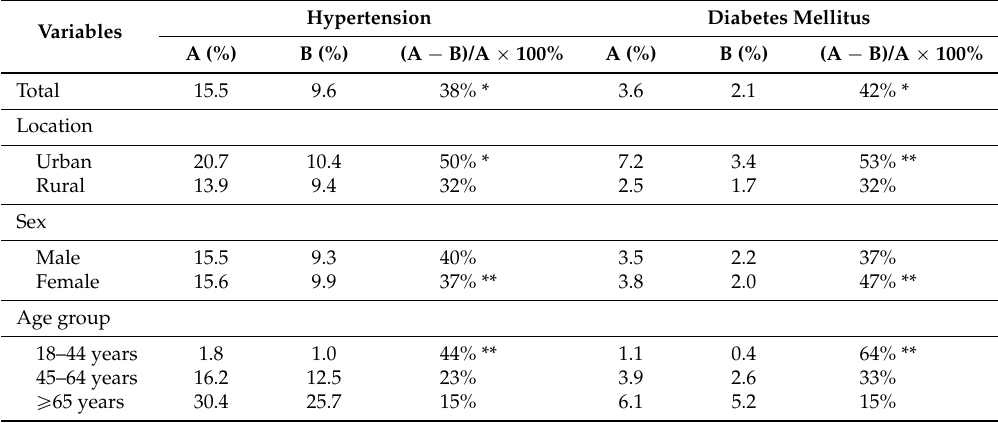
Table 2. Prevalence rates of hypertension and diabetes mellitus in residents undergoing a medical examination and not (Hunan of China,